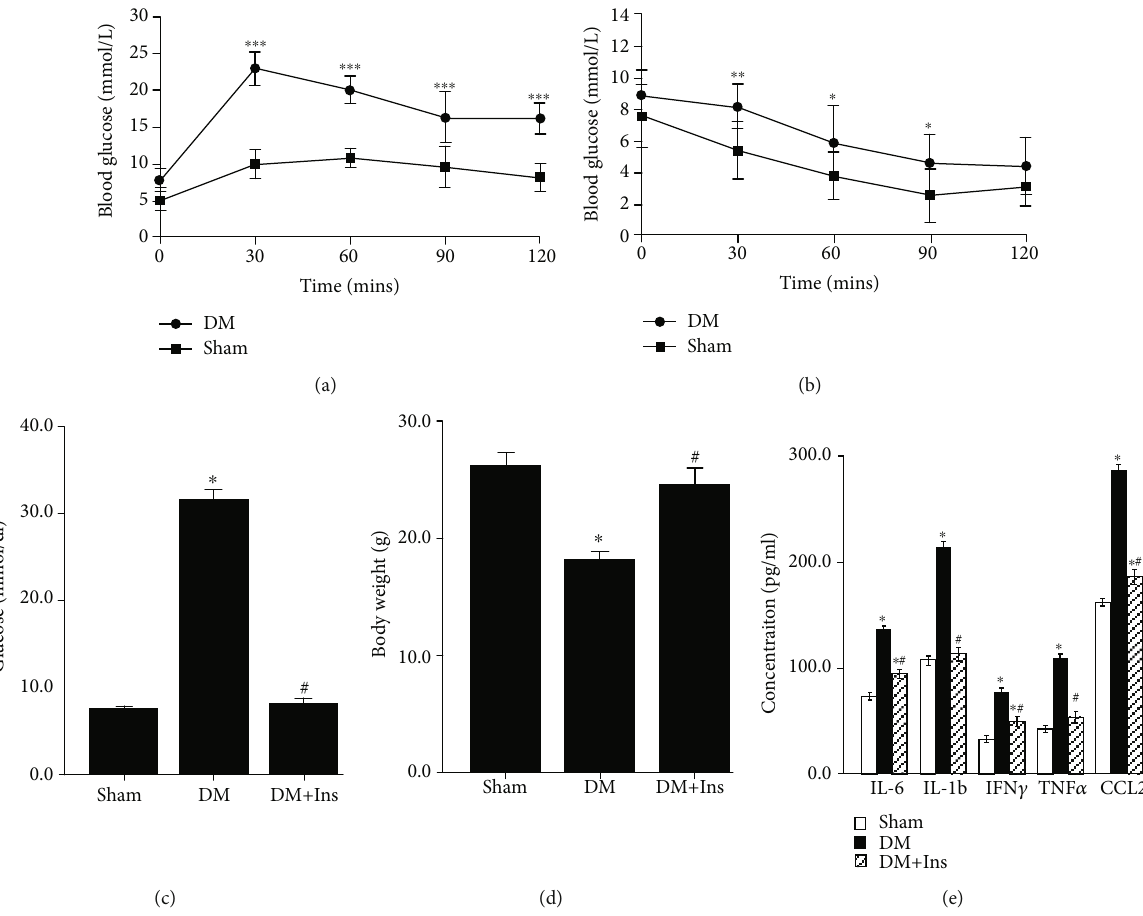
Figure 1: Insulin therapy improved condition in DM mice. (a, b) GTT (a) and ITT (b) experiments were performed to identify the DM mice. Glucose and insulin tolerance in the DM group decreased signi fi cantly, suggesting that diabetes mellitus mouse models were successfully established. (c – e) Compared with the Sham group, the blood glucose (c) of the DM group was signi fi cantly increased, and the weight (d) was signi fi cantly decreased. Besides, expressions of TNF- α , IFN- γ , IL-6, IL-1b, and CCL2 in plasma analyzed by ELISA were signi fi cantly increased (e). However, insulin treatment reversed these. Data are expressed as mean ± SED ; n = 7 ; ∗ p < 0 : 05 , ∗∗ p < 0 : 01 , and ∗∗∗ p < 0 : 001 vs. Sham group; # p < 0 : 05 vs. DM group. DM: diabetes mellitus; GTT: glucose tolerance test; ITT: insulin tolerance